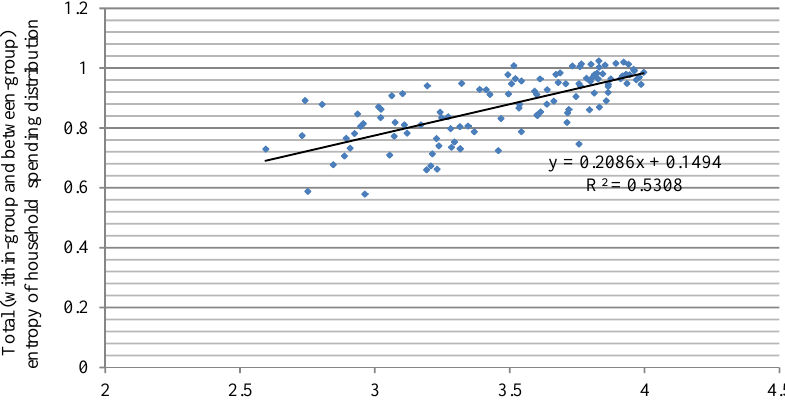
Figure 9. Linear regression for link "the absolute size of consumer spending — a measure of diversity of consumer spending (total entropy)" for 115 countries with lowest household spending"